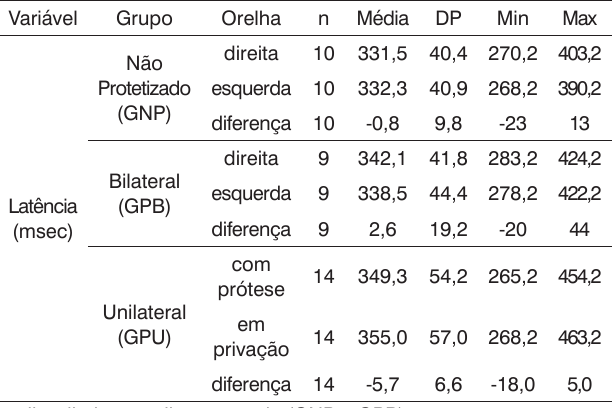
Tabela 4. Média dos valores para a amplitude (µv),